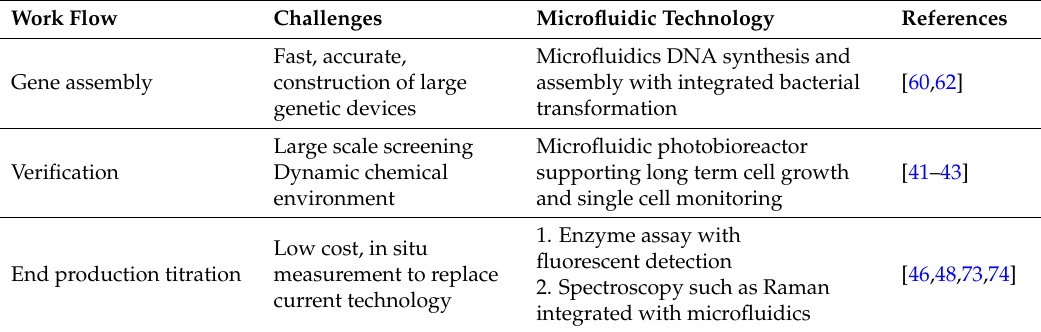
Table 1. Key microfluidic technologies for investigation of challenges present in the metabolic engineering and synthetic biology